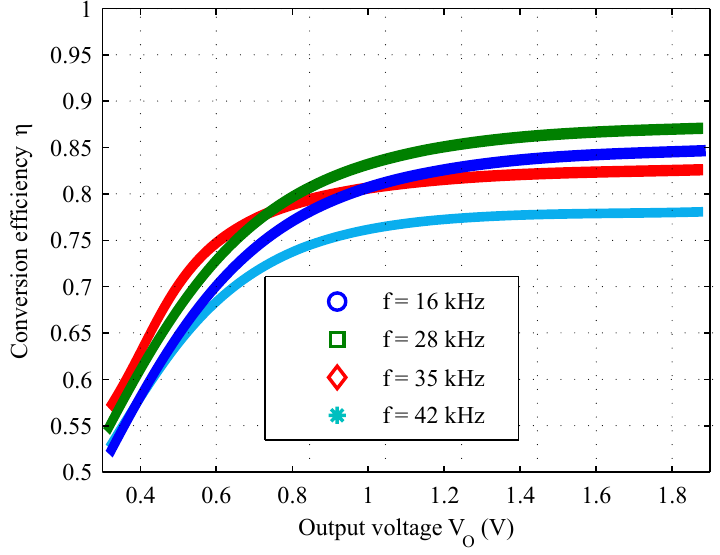
Figure 11. Efficiency as a function of the measured output voltage, considering different values of the switching frequency, driving the implemented